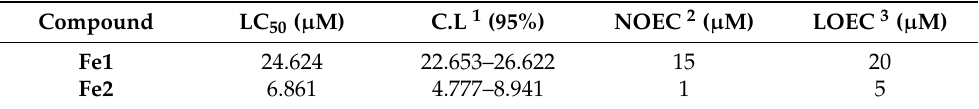
Figure 7. Mortality–response curve for Fe1 ( A ) and Fe2 ( B ). Table 2. Lethal concentration values (LC 50 ( µ M)) of zebrafish embryos subjected to tested compounds from early blastula stage up to 72 hpf calculated by Logit and Probit